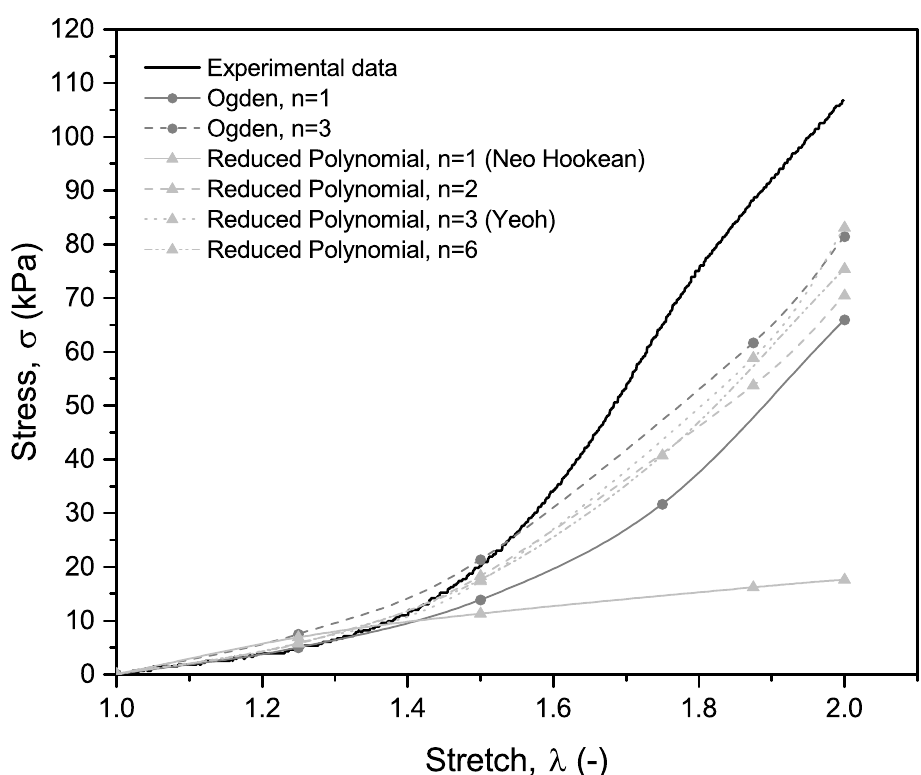
Figure 10. Comparison of longitudinal experimental mean curve (last tensile cycle) and FEM curves.